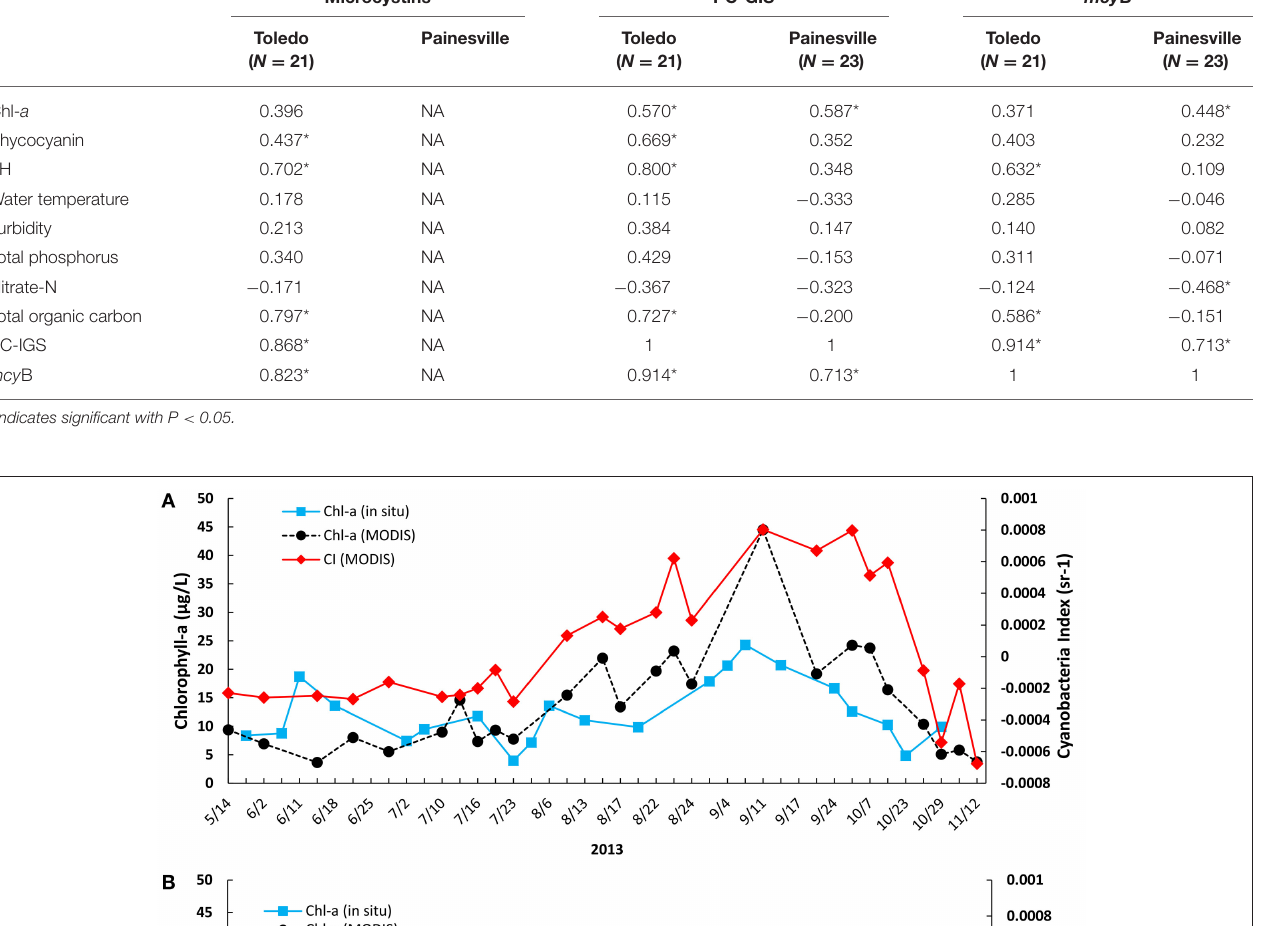
TABLE 2 | Spearman’s correlations between microcystin concentrations, the abundance of Microcystis genotypes, and limnological parameters. Microcystins PC-GIS mcy B Toledo Painesville Toledo Painesville Toledo ( N = 21) ( N = 21) ( N = 23) ( N = 21)